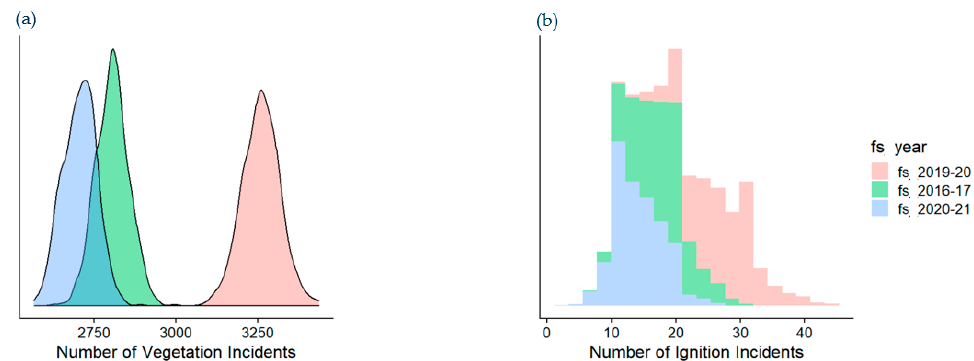
Figure 6. ( a ) Probability density plot of simulation results obtained from 1000 simulations for vegetation events across the entire network for the 2016–17; 2019–20; and 2020–21 fire seasons. ( b ) Stacked bar graph of simulation results obtained from 1000 simulations for vegetation-caused ignition events across the entire network for the 2016–17; 2019–20; and 2020–21 fire